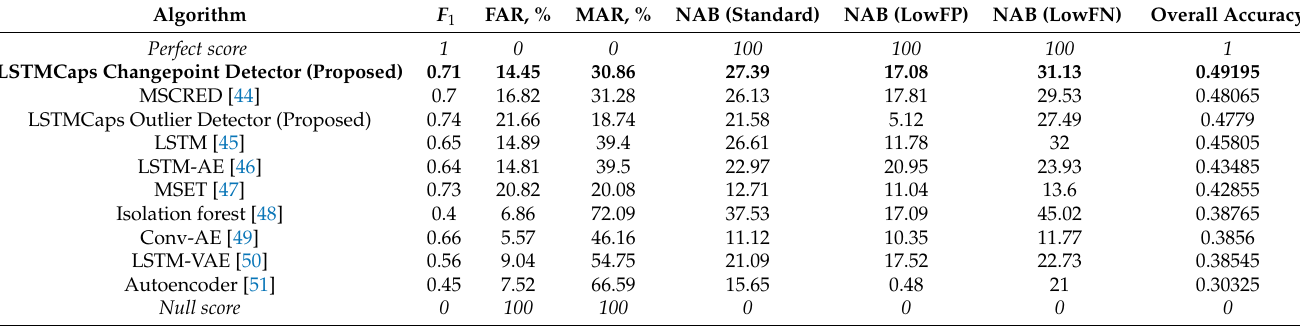
Table 11. Comparison of the average scores out of five runs for each metric tested.